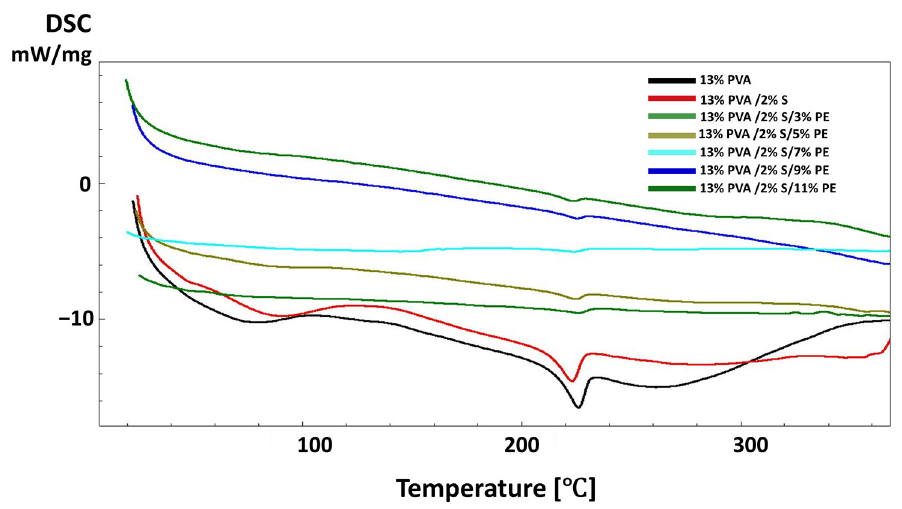
Figure 5. DSC curves of the 13% PVA ( a ), 13% PVA/1% S ( b ), 13% PVA/2% S ( c ), and 13% PVA/3% S ( d ).